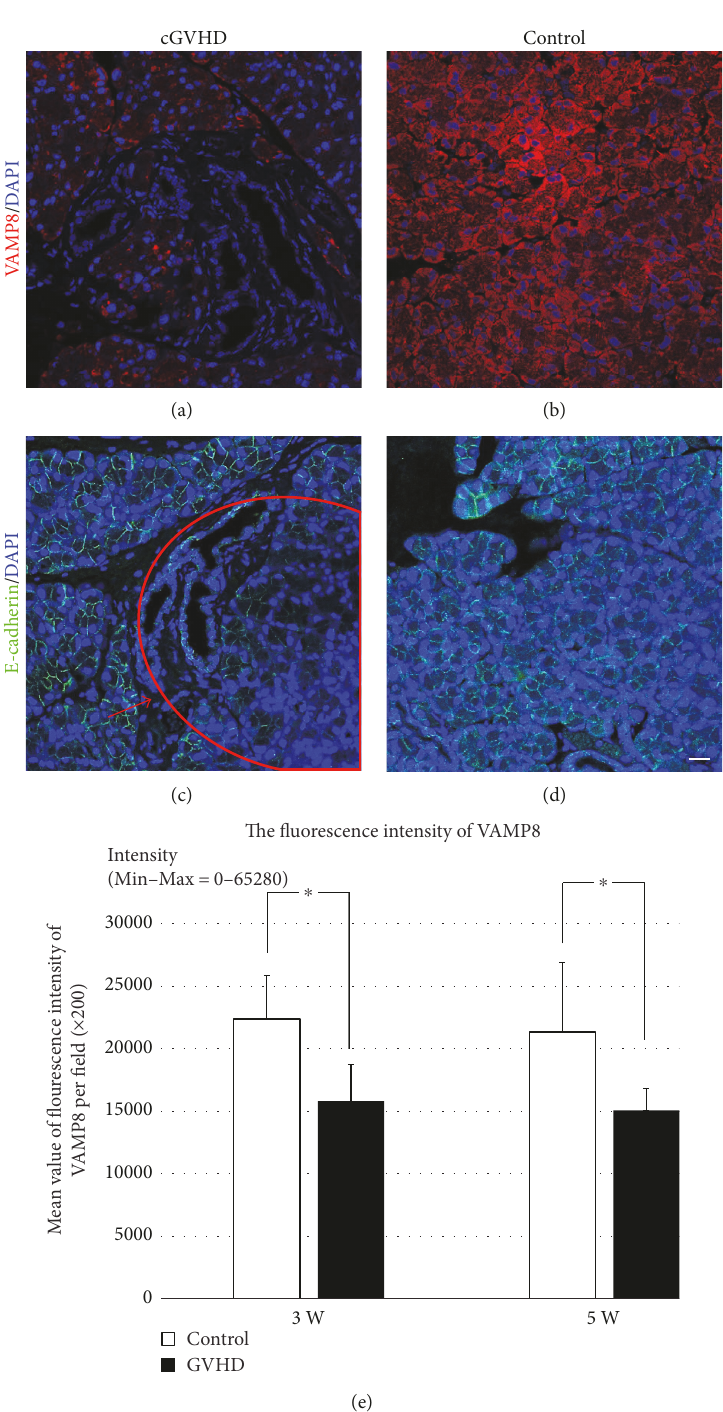
Figure 3: VAMP8 and E-cadherin expression in cGVHD-impaired murine lacrimal gland. VAMP8 expression in the lacrimal gland epithelia a ff ected by cGVHD (a) and in the syngeneic control subjects (b). E-cadherin expression in the lacrimal gland epithelia in the GVHD-a ff ected mice ((c), red boxed area, reduction of E-cadherin expression) and syngeneic control (d). VAMP8 is shown in red, E-cadherin in green, and 4 ′ ,6-diamidino-2-phenylindole (DAPI) in blue. Scale bar =25 μ m (a, b, c, and d). The vertical axis shows the average of fl uorescence intensity of VAMP8 measured by ImageJ (e). The intensity of VAMP8 in the syngeneic control and GVHD-a ff ected mice at the 3 and 8 weeks after bone marrow transplantation. N = 4 – 5 . Bar=mean ± SD. ∗ p < 0 05 , p = 0 012 at 3 weeks, p = 0 042 at 8 weeks. cGVHD mice, n = 10 ; syngeneic control mice, n = 10 . The experiments were repeated three